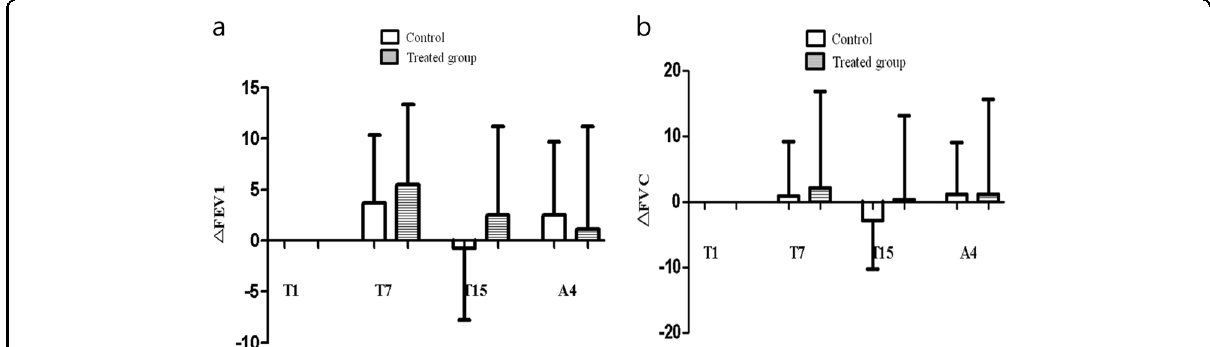
Fig. 8 Change in pulmonary function tests (PFTs) [ a change in forced expiratory fl ow in 1 s ( Δ FEV 1 ) and b change in forced vital capacity ( Δ FVC)] during and after fi broblast growth factor (FGF)-2 treatment. PFTs, including FEV1 and FVC, tended to improve during the recombinant (r) FGF-2 treatment period but not signi fi cantly between the rFGF-2 group and the control group ( p > 0.05)